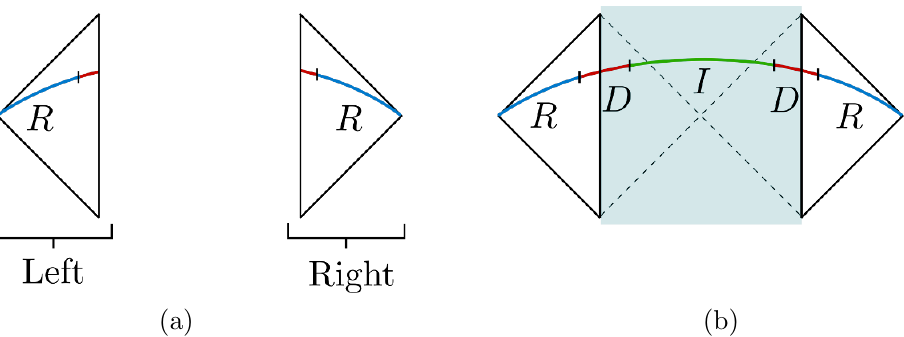
Figure 16 . (a) The full Hilbert space is the product Hilbert space of the entire left and right (cid:13)at space regions including the boundary points. The region R we are interested in is a union of two subregions in the two (cid:13)at space regions. (b) The e(cid:11)ective state used in the island prescription is the semi-classical state de(cid:12)ned on the Cauchy slice of the full system. R is the same region in the (cid:13)at space region whose exact entropy we are computing, I is the island, and D is the complement of the